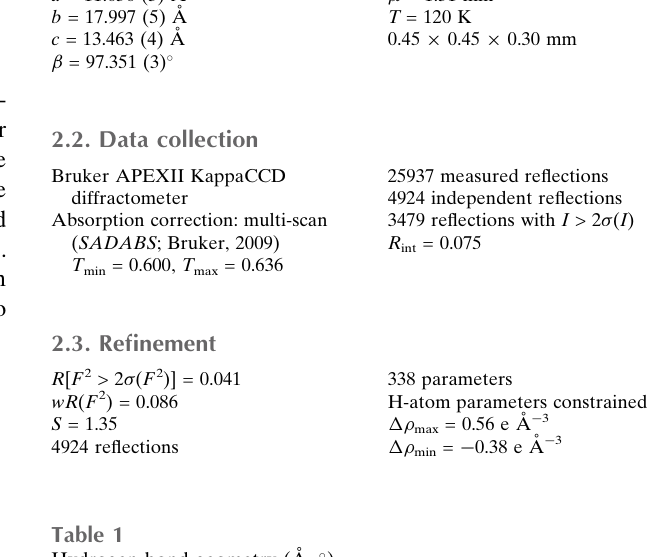
Hydrogen-bond geometry (A˚ , (cid:3) ). Cg 1 is the centroid of the N1/C1–C4